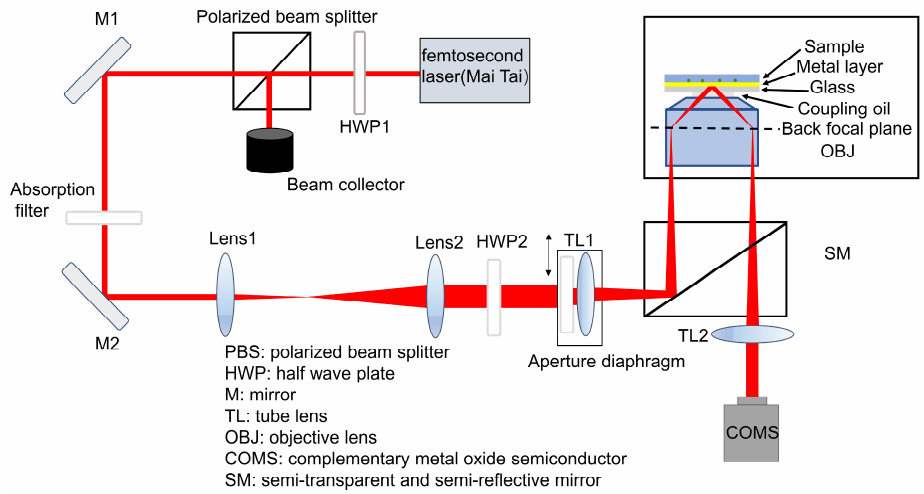
Figure 1. Schematic of total internal reflection ‐ surface plasmon resonance microscopy.